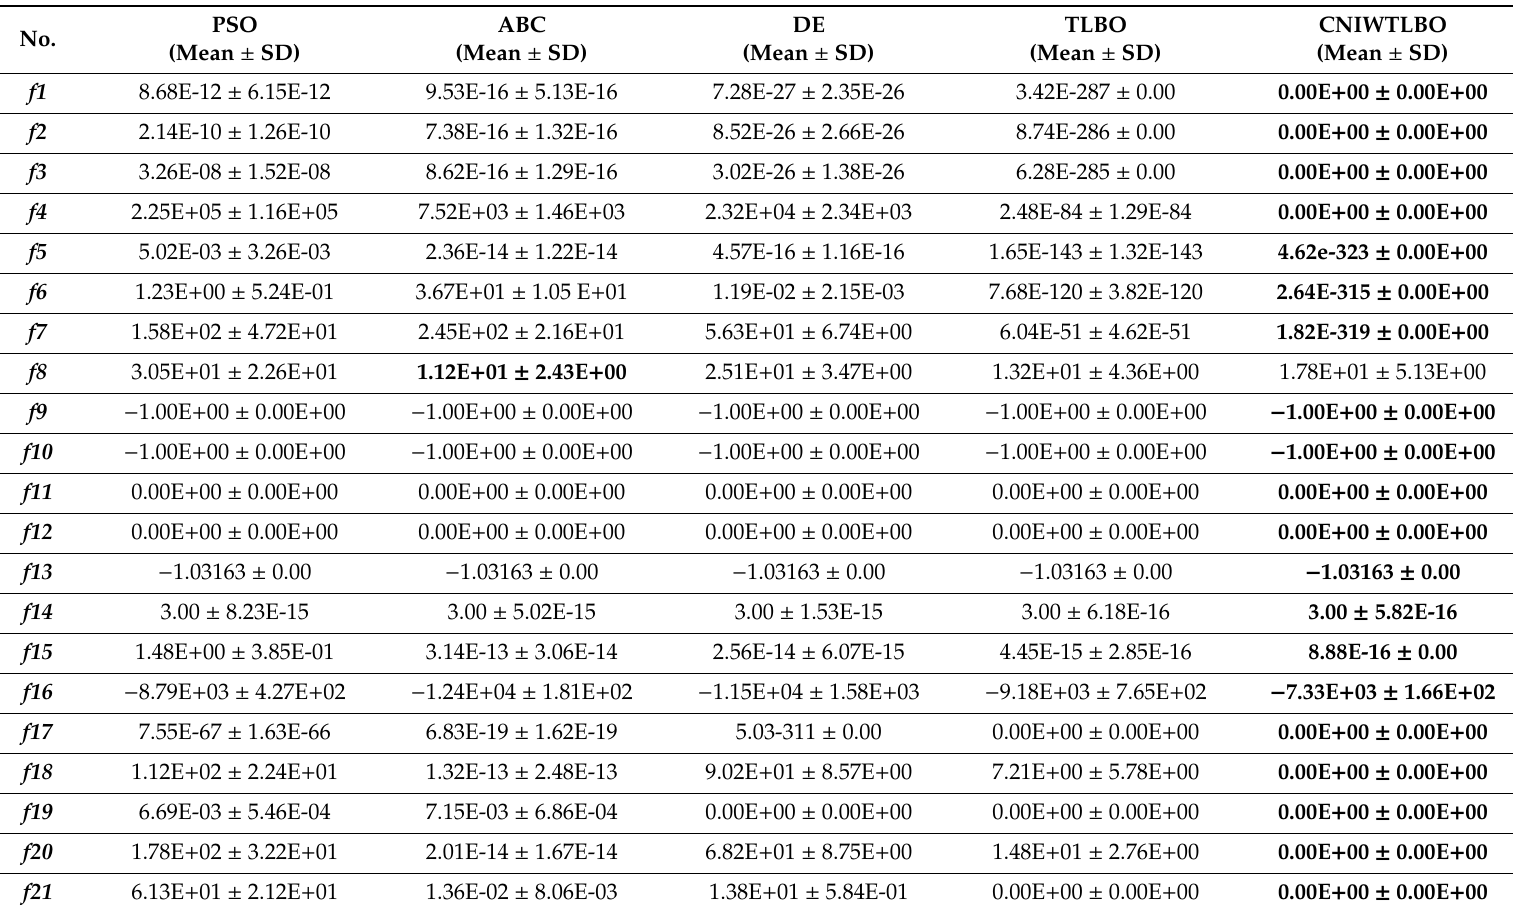
Table 3. Performance comparisons of PSO, ABC, DE, TLBO, CNIWTLBO in term of fitness